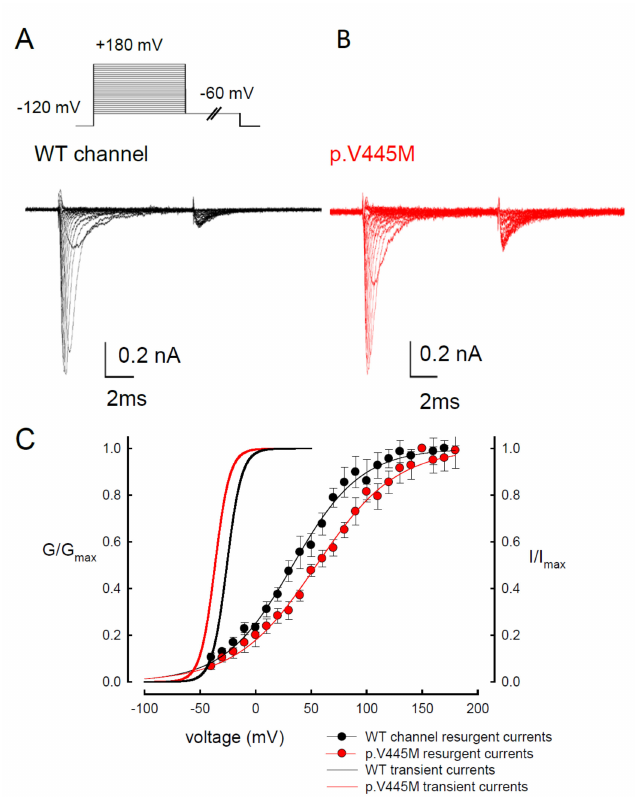
Figure 5. Activation curve of resurgent Na + currents in the CHO-K1 cells ( A ) The protocol to generate resurgent Na + currents are as follows: the cell was held at − 120 mV for ~30 ms, and then stepped to various depolarization between − 60 and + 180 mV for 5 ms in 10 mV increments. Resurgent Na + currents were then evoked by a pulse of − 60 mV for 150 ms (upper panel). Sample sweeps were obtained in the presence of 0.1 mM Na v β 4 peptide for the WT channel (lower panel). ( B ) Sample sweeps for the p.V445M mutant channel in the presence 0.1 mM Na v β 4 peptide. ( C ) The activation curves of transient and resurgent Na + currents for the WT and p.V445M mutant channels are replotted for comparison. The activation curve of resurgent Na + currents of the WT channel (the block point fitting line) for each cell are obtained by fittings with Boltzmann functions, and the cumulative results for V h are + 33.64 ± 1.7 mV and k are 30.45 ± 1.45 for ~10 ms prepulses, respectively ( n = 8). The resurgent activation curve of the p.V445M mutant channel (the red-point-fitting line) for each cell are also obtained by fitting Boltzmann functions and the cumulative results for V h and k are + 54.04 ± 1.43 mV ( n = 6) and 33.84 ± 1.12 ( n = 6), respectively